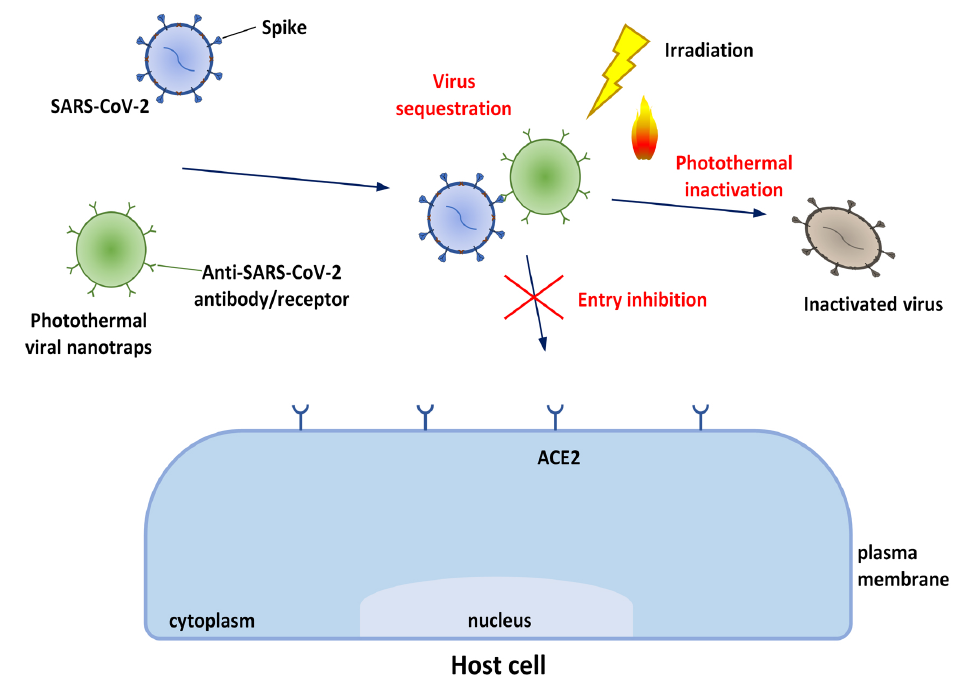
Figure 15. Schematic representation of nanomaterials for virus sequestration and photothermal